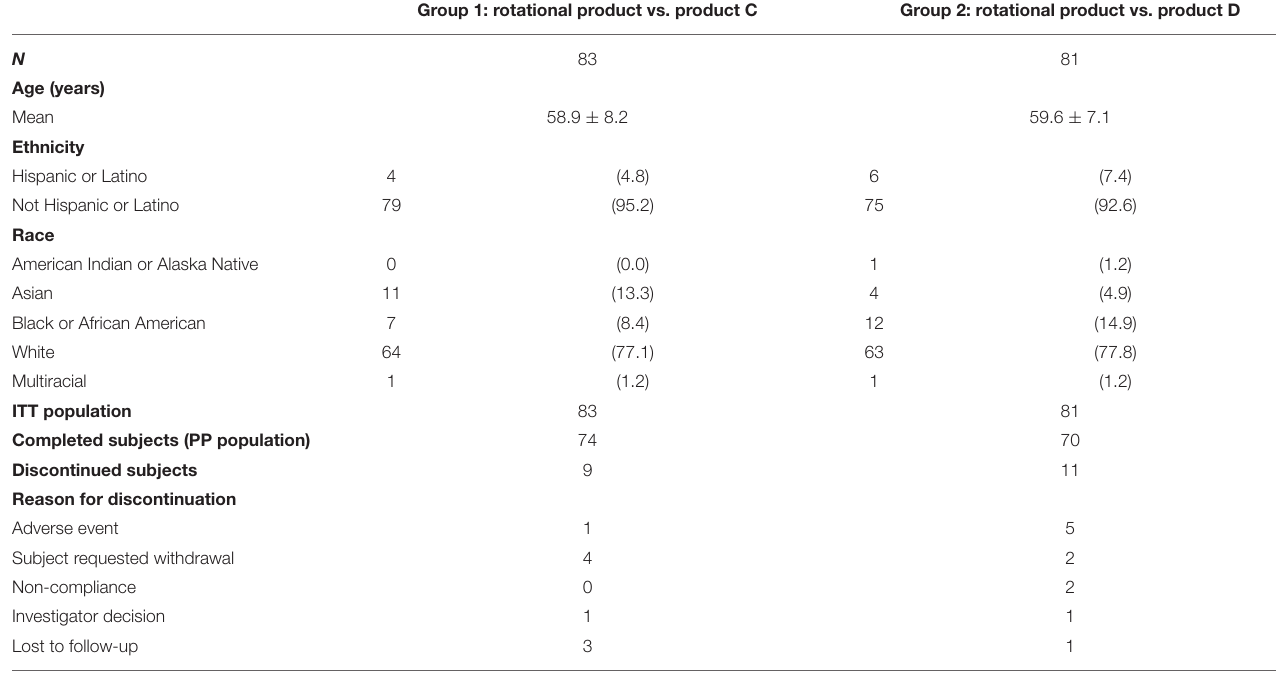
Group 1: rotational product vs. product